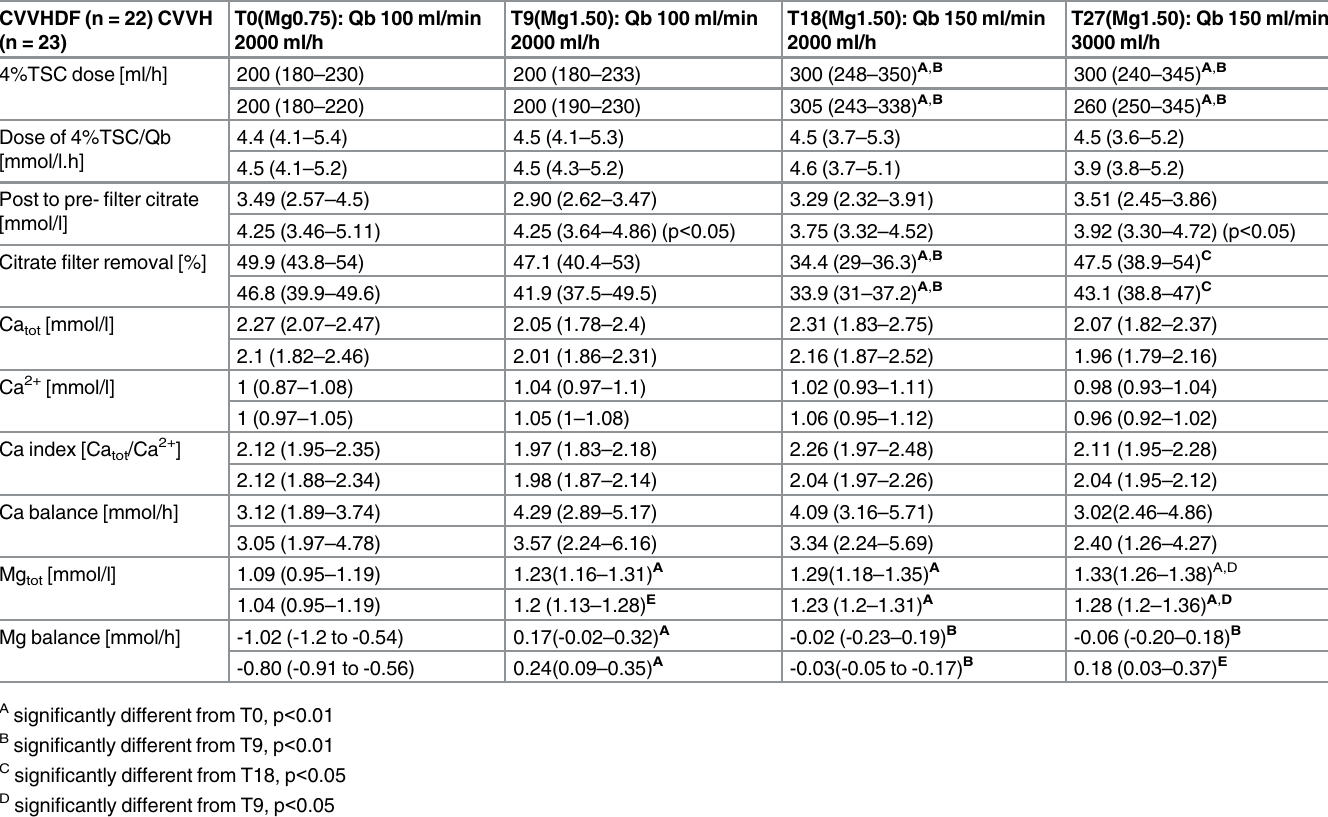
Table 1. The results (median, IQR) are given separately for the CVVHDF (the first row) and CVVH (the second row) subgroups. Differences between CVVHDF and CVVH reached statistical significance for post to pre-filter citrate difference (p < 0.05) at T9(Mg1.50), T27(Mg1.50) and for Mg balance at T27 (Mg1.50) (p = 0.02). Comparisons between T0(Mg0.75) and T9(Mg1.50), T18(Mg1.50), T27(Mg1.50) are given separately for CVVHDF and CVVH where sta- tistically significant. CVVHDF (n = 22) CVVH (n = 23)